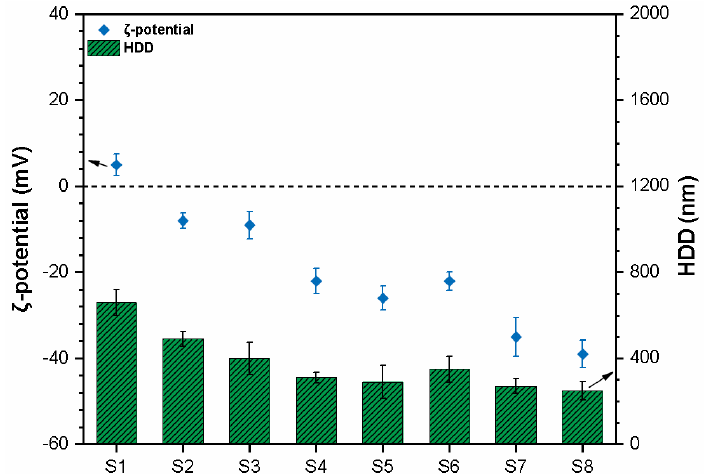
Figure 3. Corresponding ζ -potential and HDD profile of ZnO NPs (30 mg/L) dispersed in synthetic waters (S1–S8) at pH 7.